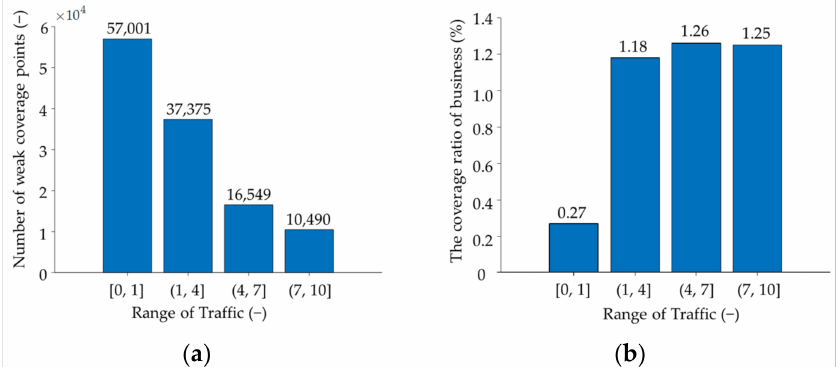
Figure 1. Data comparison of weak coverage points in different traffic sections. ( a ) corresponds to number of the weak coverage points, ( b ) corresponds to the coverage ratio of the business. The weak coverage points in the traffic range of 0 to 1, 4, 7 and 10 are stacked and filtered one after the other. After comparative analysis, the weak coverage points with traffic volume less than 4 are defined as a “noise point”.